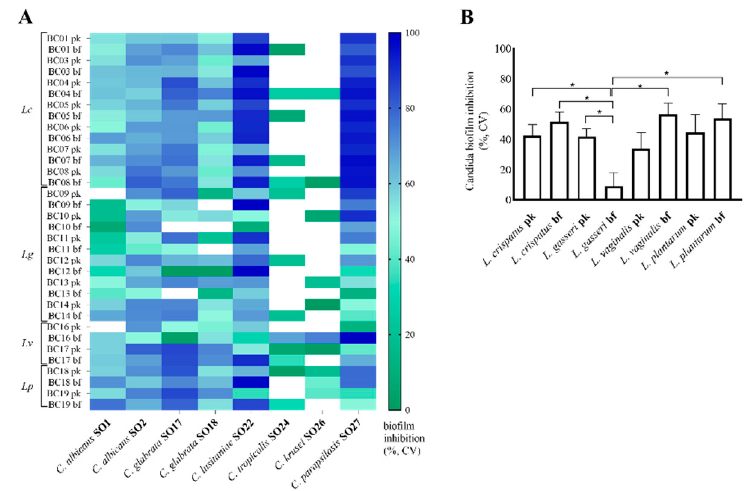
Figure 2. Inhibition of Candida isolate biofilm formation by lactobacilli pk-CFS and bf-CFS, eval- uated by crystal violet (CV) staining. ( A ) Heatmap of biofilm inhibition percentage, calculated over corresponding Candida growth control. White squares indicate the absence of inhibition and stimu- lation of biofilm formation. ( B ) Average ± SEM of biofilm inhibition percentages, grouped for Lacto- bacillus species and mode of growth (pk/bf). Lc, Lactobacillus crispatus ; Lg, Lactobacillus gasseri ; Lv,